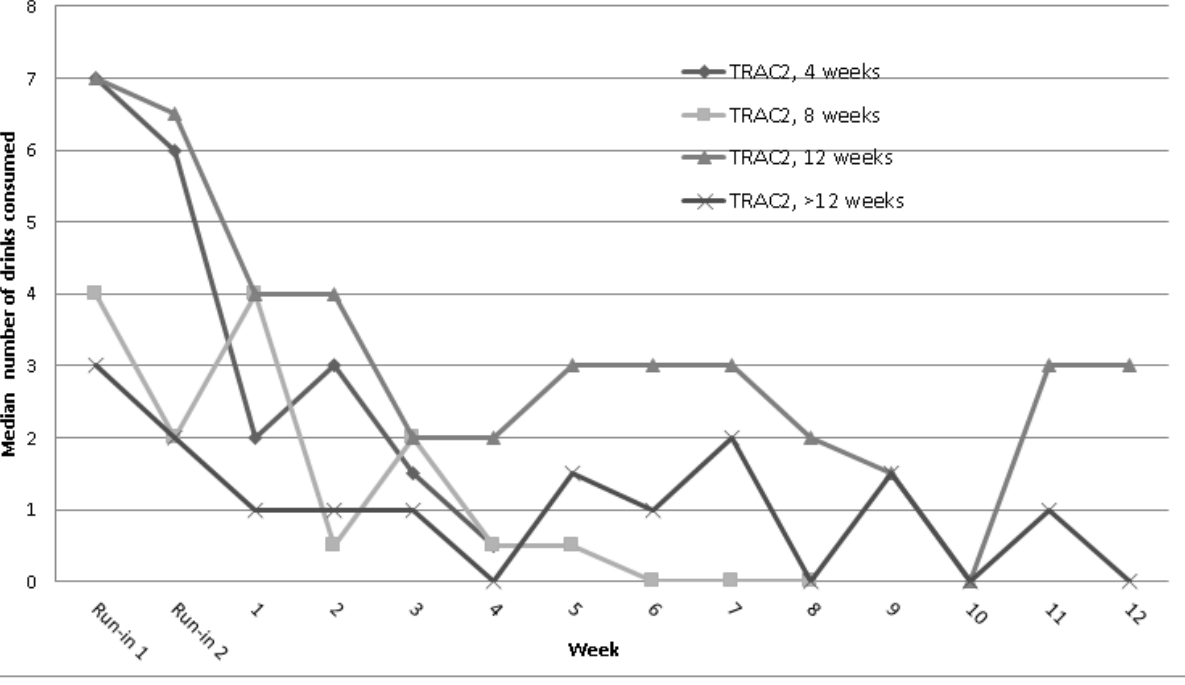
Figure 3. Median maximum drinks consumed over weekends by length of intervention engagement. Included are ecological momentary assessment (EMA) reports over the 2-week run-in to show changes that occurred before Texting to Reduce Alcohol Consumption 2 (TRAC2) intervention exposure (assessment reactivity).